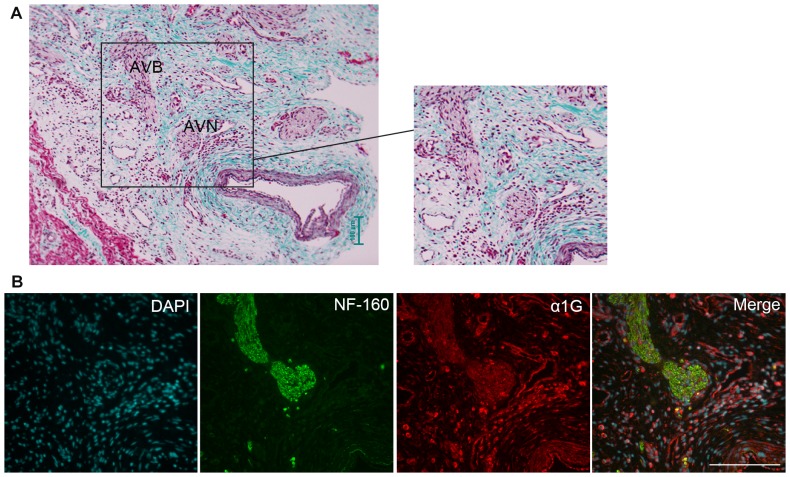
T-type calcium channel α1G is expressed in the AV node of human fetal hearts.(A) Masson's trichrome staining of 21-week human fetal heart demonstrates morphology of the AVJ region with light pink staining of the spindle-like cells in the AV node (AVN) and the AV bundle (AVB), green staining corresponding to collagen fibres. (B) α1G staining (Red) is present in AVJ and AV bundle regions which are distinguishable by positive NF-160 staining (Green). Scale bars represent 100 µm (A) and 150 µm (B).